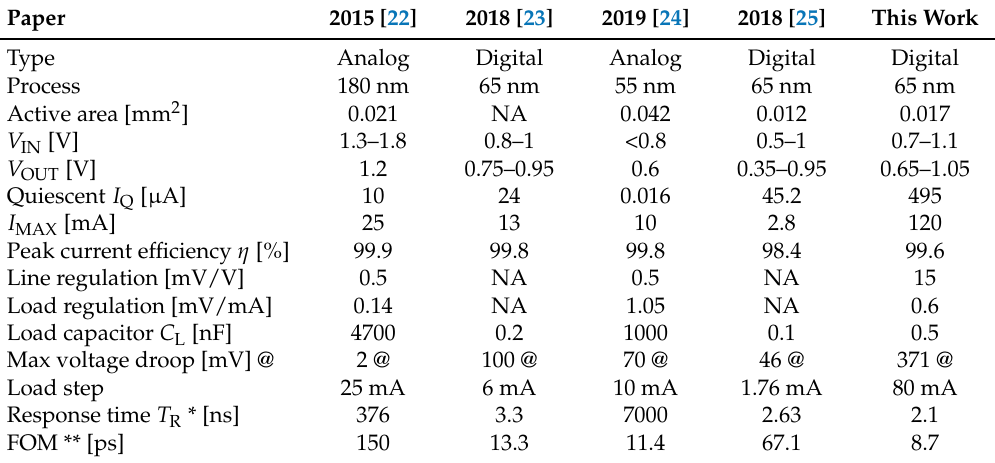
Table 2. Comparison with published LDO